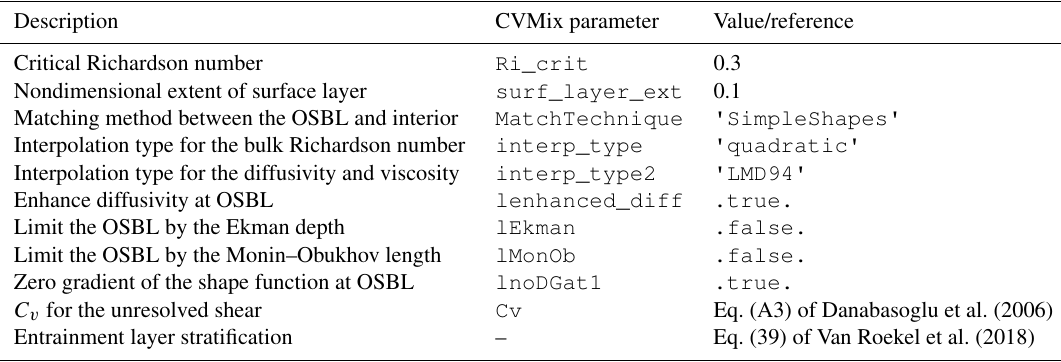
Table 1. Summary of parameters and settings in KPP-CVMix. Description